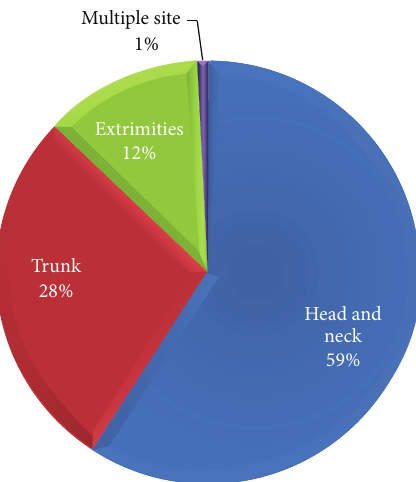
Figure 1: Percent of anatomical distribution of rashes.